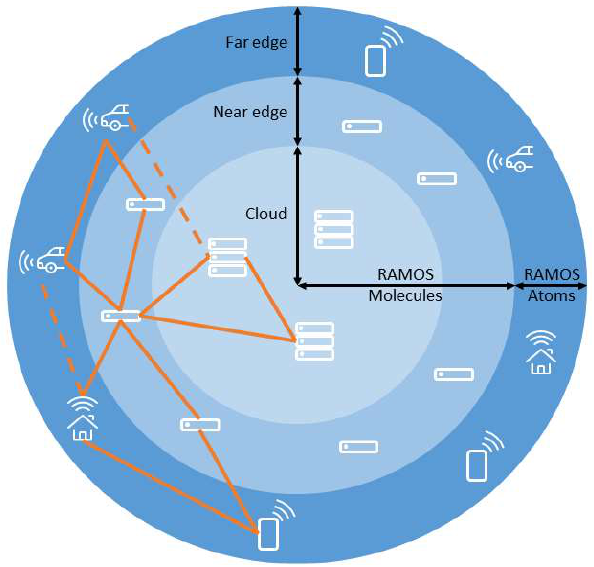
Figure 1. Constellation of RAMOS nodes towards a peer-to-peer continuum.